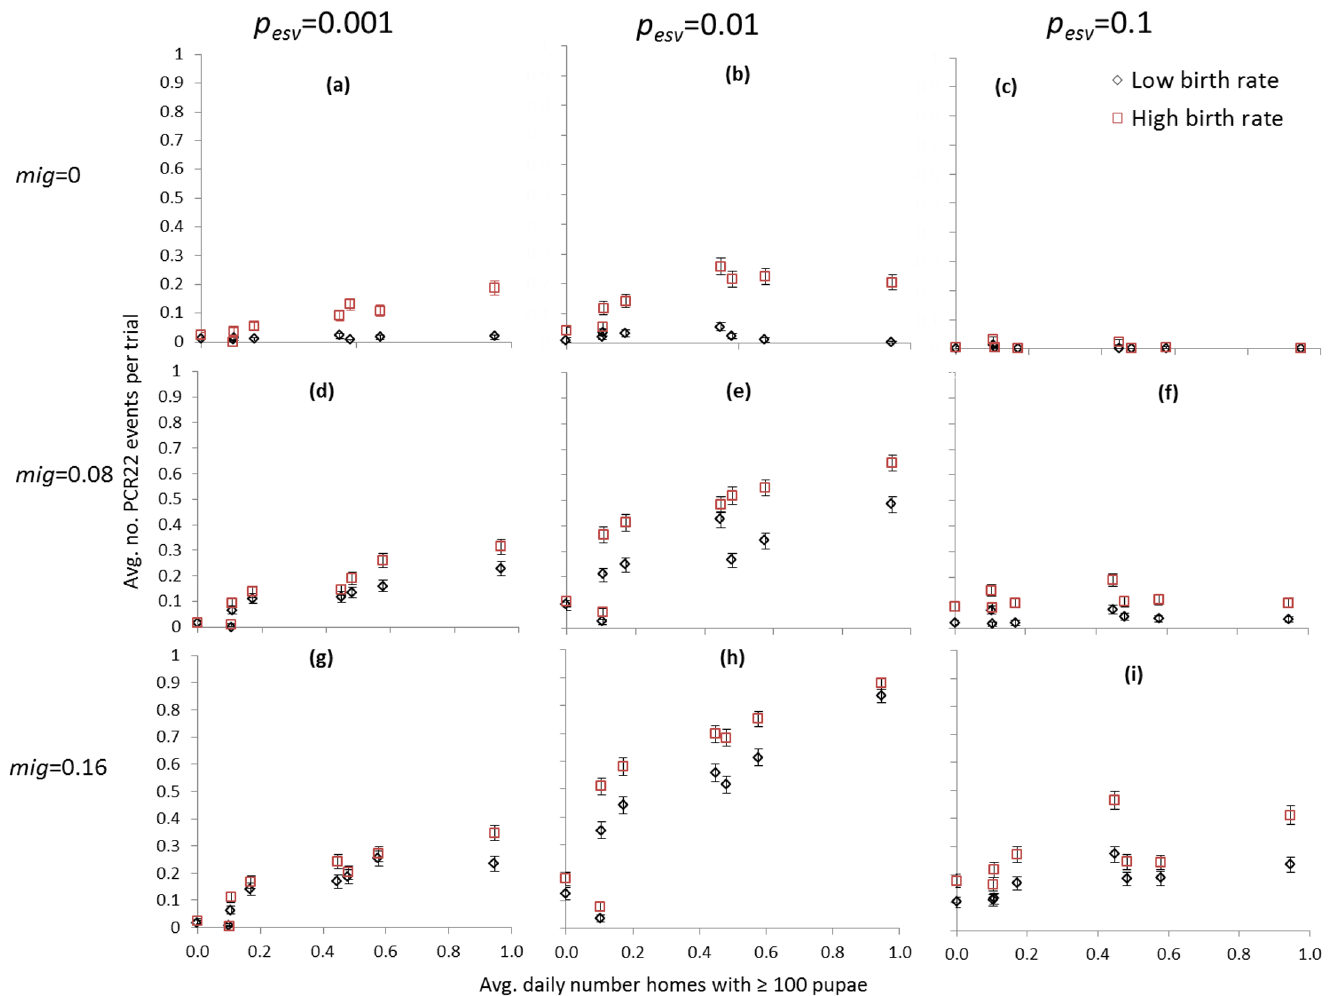
Fig 4. Number of PCR22 events 11 – 20 years post invasion (y-axis), averaged across 250 trials (s.e.) for each combination of p esv and mig as shown in Figs 1 and 2. Birth rate averages 0.05 – 0.1 annual births/house in the low group and 0.2 – 0.25 annual births/house in the high